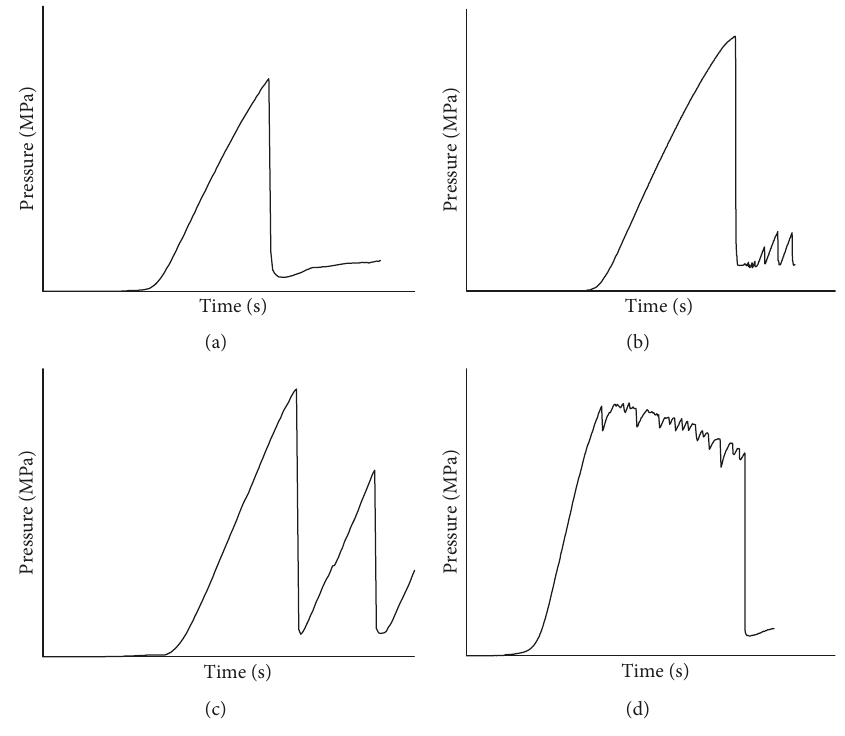
Figure 24: Some kinds of pressure